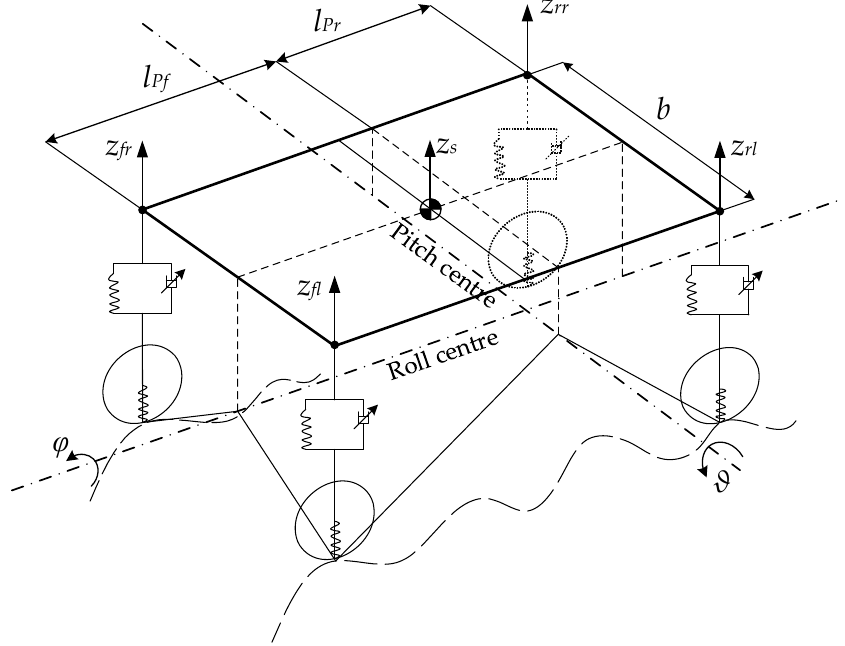
Figure 8. Schematic of the utilized vehicle model. Roll and pitch centre kinematics is relevant to the estimation of the suspension top-mount positions.